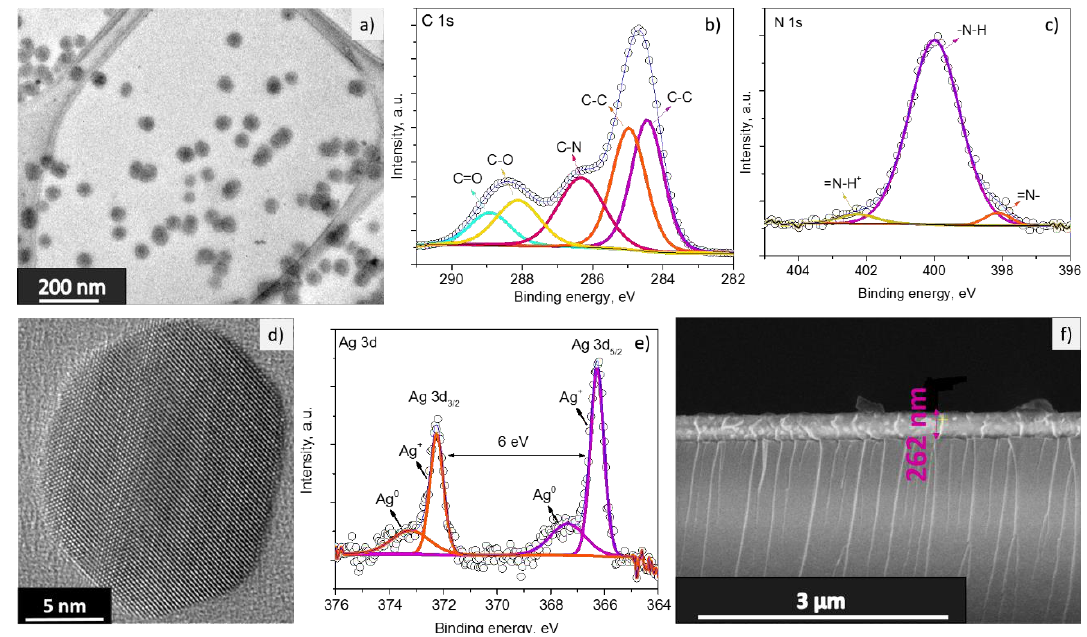
Figure 2. TEM image of PPy NPs ( a ); high-resolution XPS spectra of the C 1s ( b ) and N 1s ( c ) core levels at the PPy NPs; HR-TEM image of the Ag NPs ( d ); high resolution XPS spectra of the Ag 3d core levels at the Ag NPs ( e ); typical cross-section SEM image of the L-SAW sensors after spin coating of PPy or Ag/PPy NPs ( f ).